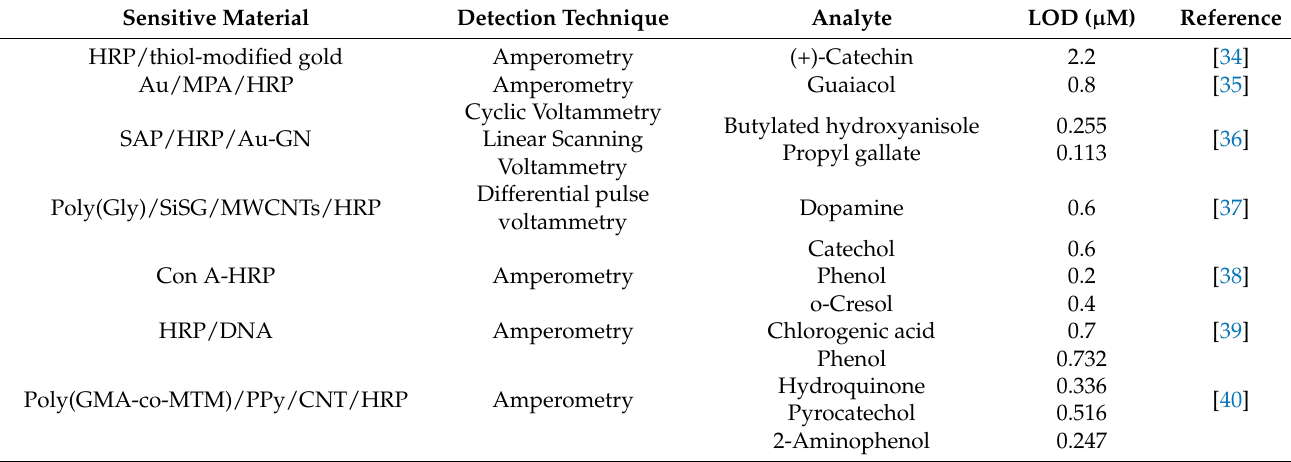
Table 1. Peroxidase-based biosensors used to detect phenolic compounds. Sensitive Material Detection